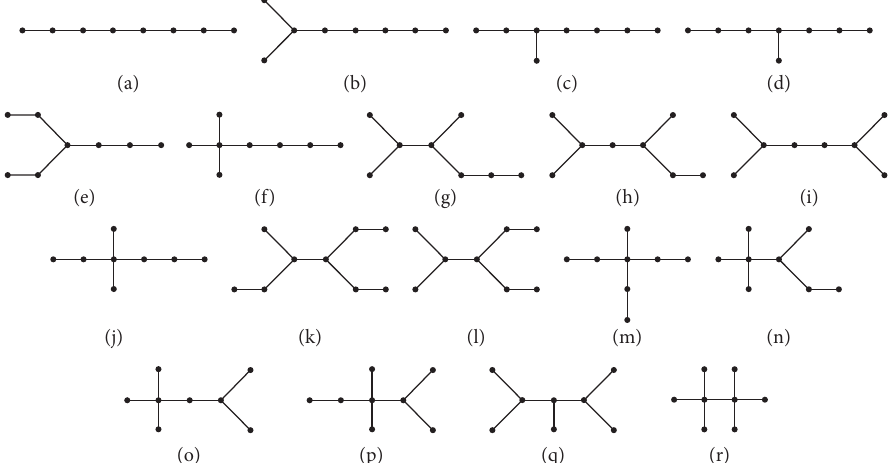
Figure 1: Graphs of octane isomers. (a) O 1 . (b) O 2 . (c) O 3 . (d) O 4 . (e) O 5 . (f) O 6 . (g) O 7 . (h) O 8 . (i) O 9 . (j) O 10 . (k) O 11 . (l) O 12 . (m) O 13 . (n) O 14 .